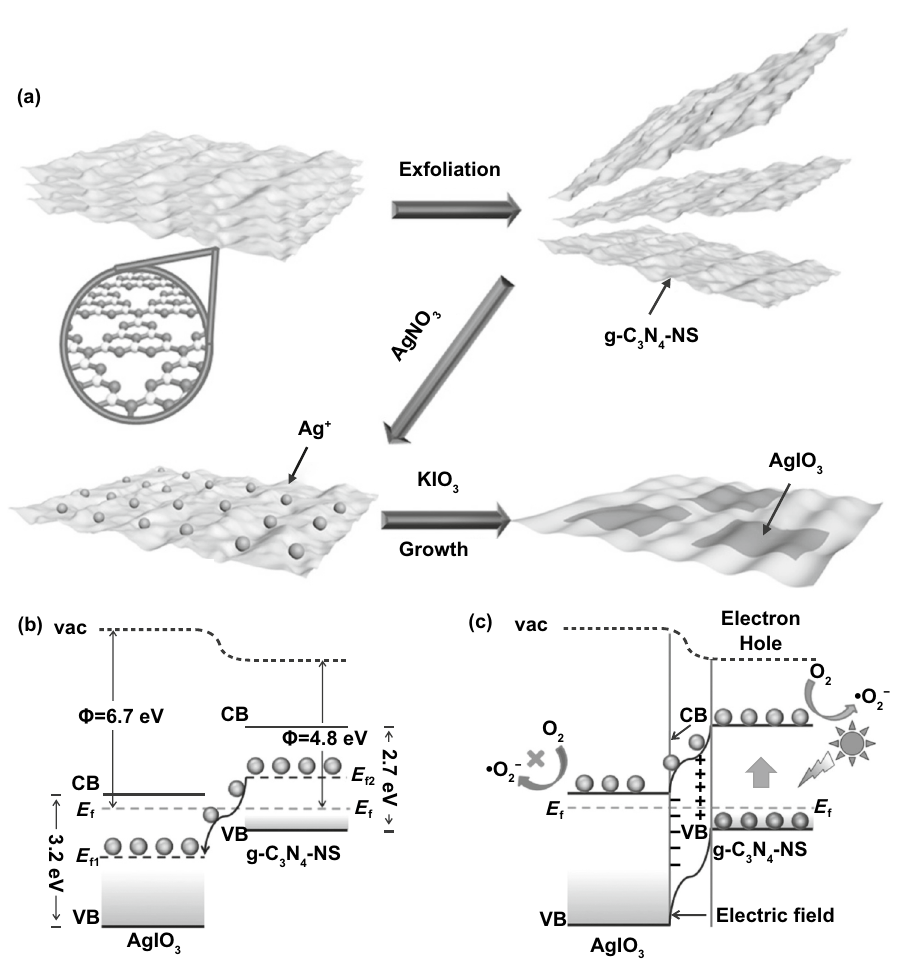
Fig. 26 a Scheme showing AgIO 3 /g‑C 3 N 4 ‑NSs composite synthesis. b Photo‑catalytic degradation kinetics of RhB after vis‑light irradiation. c Scheme showing charge separation at AgIO 3 /g‑C 3 N 4 ‑NS interface after vis‑light irradiation. Adapted with permission from Ref.